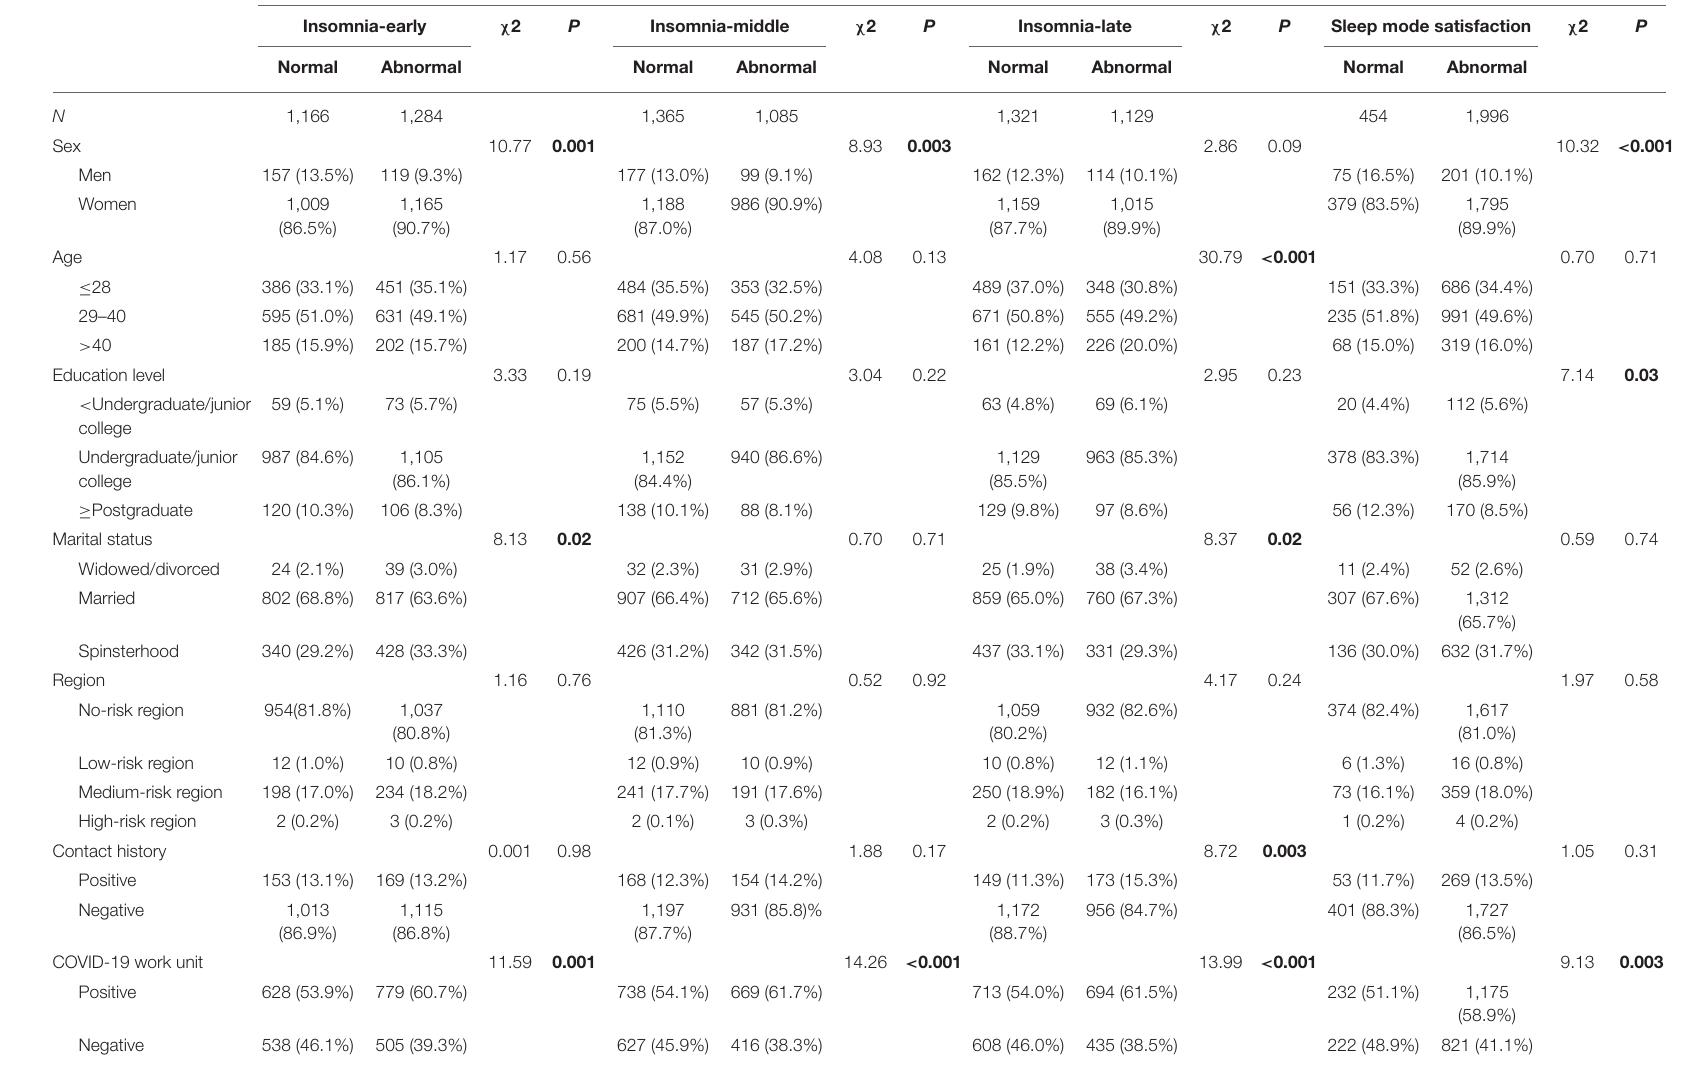
The bold values indicate that the differences are statistically